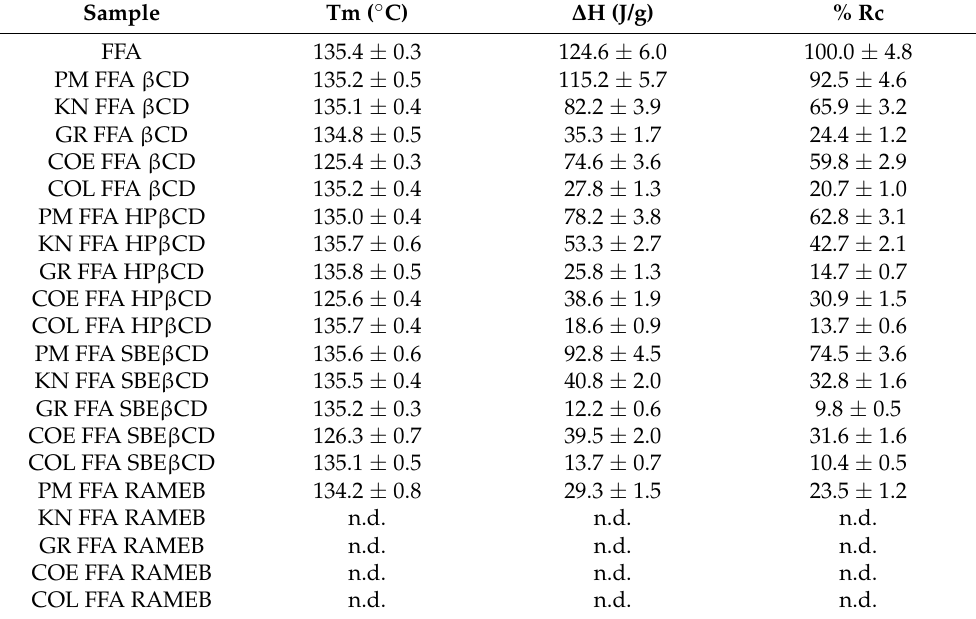
Table 2. Melting temperature (Tm), enthalpy of fusion ( ∆ H) and % residual crystallinity (% Rc) of FFA in its binary systems obtained by physical mixing (PM), kneading (KN), co-grinding (GR), coevaporation (COE) and co-lyophilisation (COL) with β CD, HP β CD, SBE β CD and RAMEB. Sample Tm ( ◦ C) ∆ H